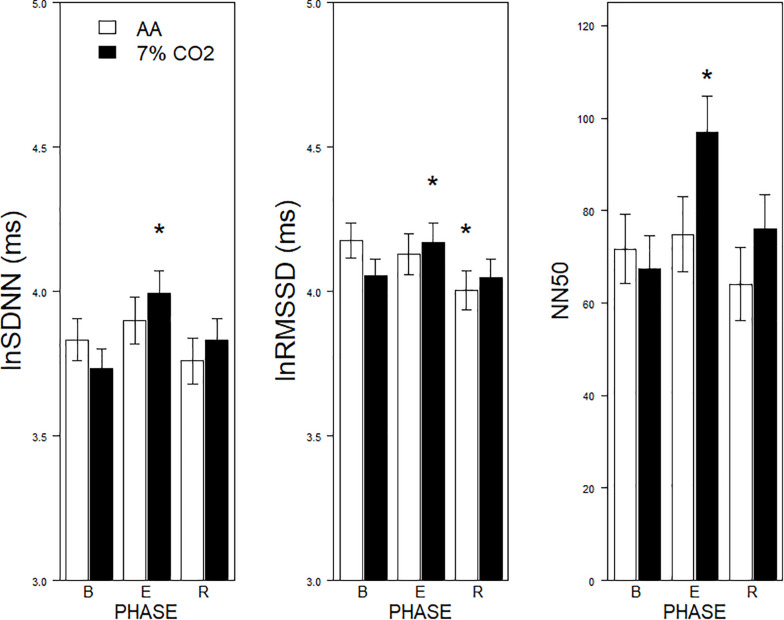
Effects of 7% CO2 on measures of Time Domain HRV across the three experimental phases. Three measures of the Time Domain in HRV are depicted from left to right panels, SDNN, RMSSSD, and NN50, respectively. The legend for all three panels is contained in the left panel. For all three measures, ∗ indicates a significant change from baseline, p < 0.05. For NN50, ∗ additionally indicates a difference in recovery, p < 0.05.